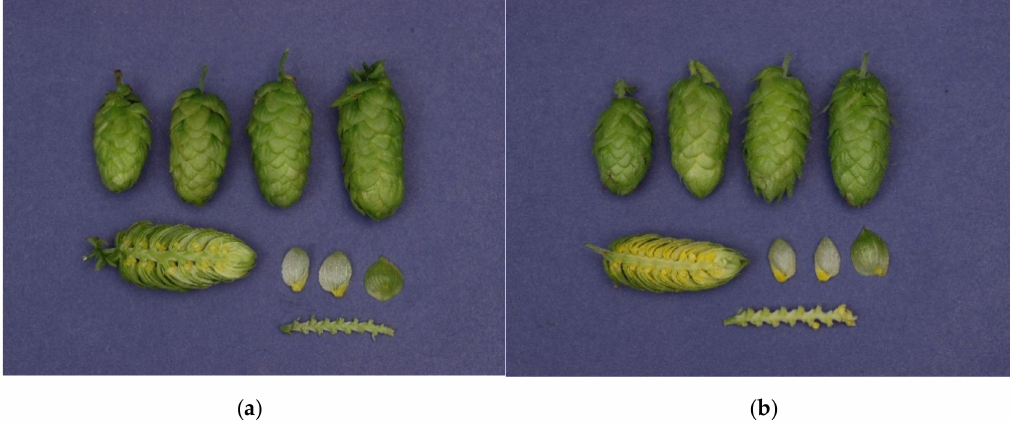
Figure 2. Hop cone size variation in varieties ( a ) Hallertauer Tradition, ( b ) Hallertauer Herkules